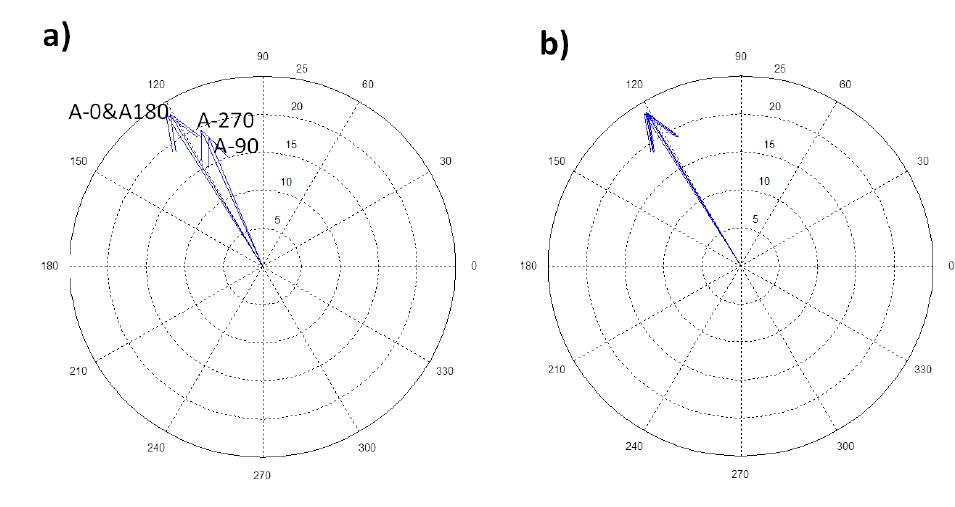
Figure 8. Polar plot of the sensors. ( a ) Before calibration of PZTs; ( b ) After calibration of